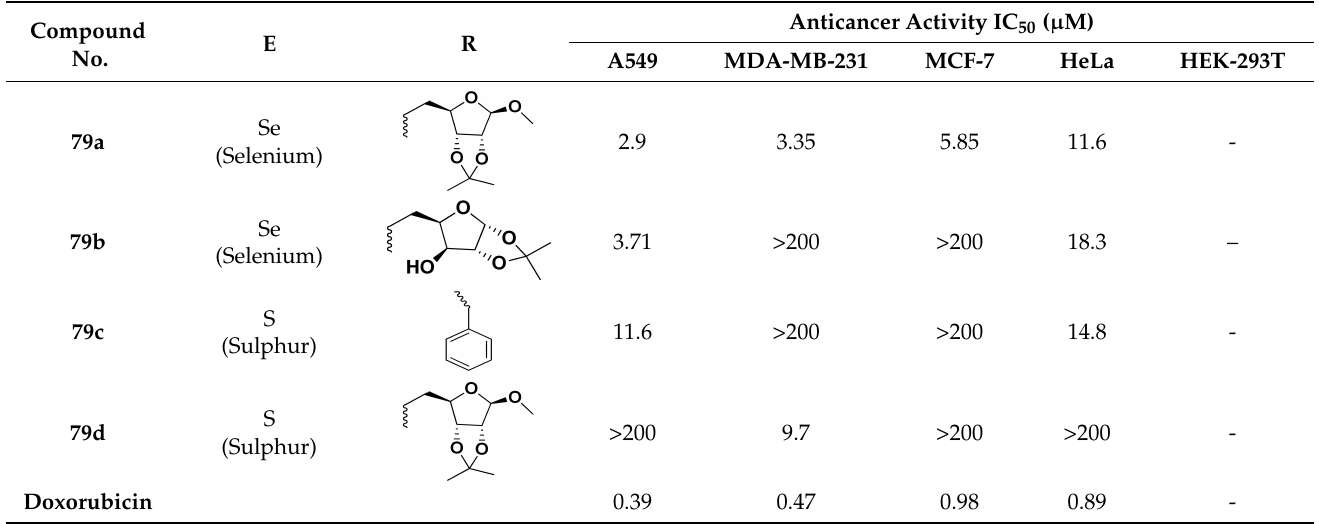
Table 65. In vitro cytotoxic activities of ferrocene-chalcogeno (sugar) triazole conjugate compounds 79 ( a – d ).